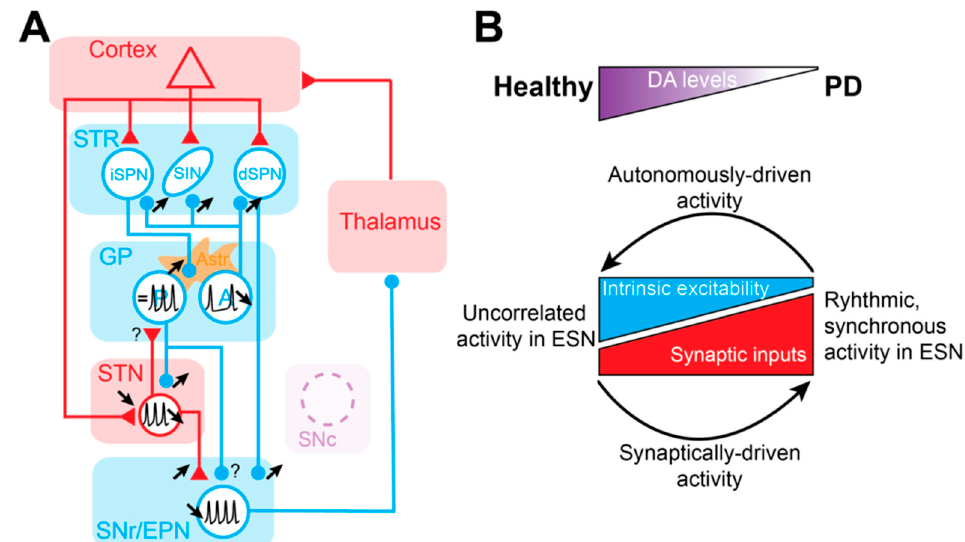
Figure 4. Cellular and synaptic alterations in the ESN in experimental PD. ( A ) Summary diagram of the main modifications in cellular excitability and synaptic transmission observed in the BG network under DA-depleted conditions. Black arrows indicate increase or decrease in synaptic transmission or intrinsic excitability (represented by black APs). Astr.: astrocyte involvement in GABAergic dysfunction in GP. GABAergic and glutamatergic projections and nuclei are depicted in blue and red, respectively. Loss of SNc DA neurons is represented by the dashed purple circle. ( B ) Schematic illustrating the modification in the balance between intrinsic neuronal excitability and synaptic strength in ESN as a function of the levels of DA.